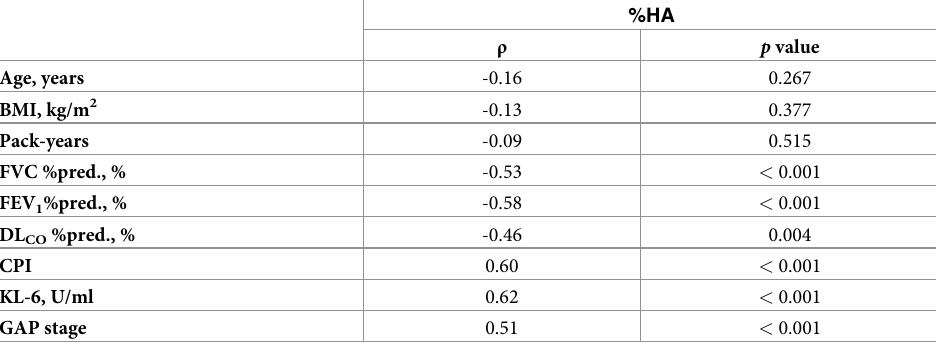
Table 2. Relationship between patient characteristics and %HA determined by quantitative CT analysis.